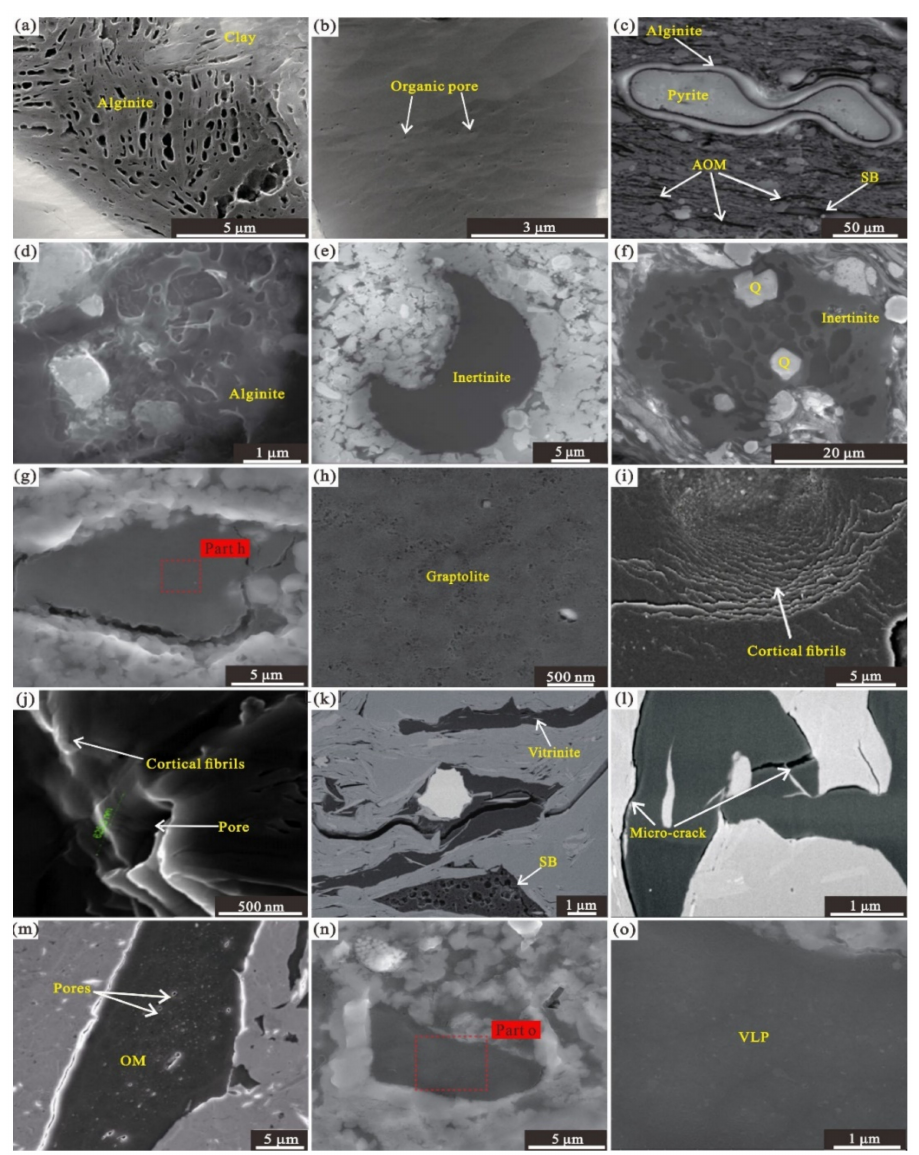
Figure 3. SEM photographs showing pores characteristics of different types of macerals. (Explanation: AOM = amorphous organic matter; SB = solid bitumen; Q = quartz; VLP = vitrinite-like particle.) ( a ) The pores in the alginite of Longmaxi Formation shale in the Sichuan Basin show an orientated distribution [20]. ( b ) Secondary pores were developed in the alginite of Longmaxi Formation